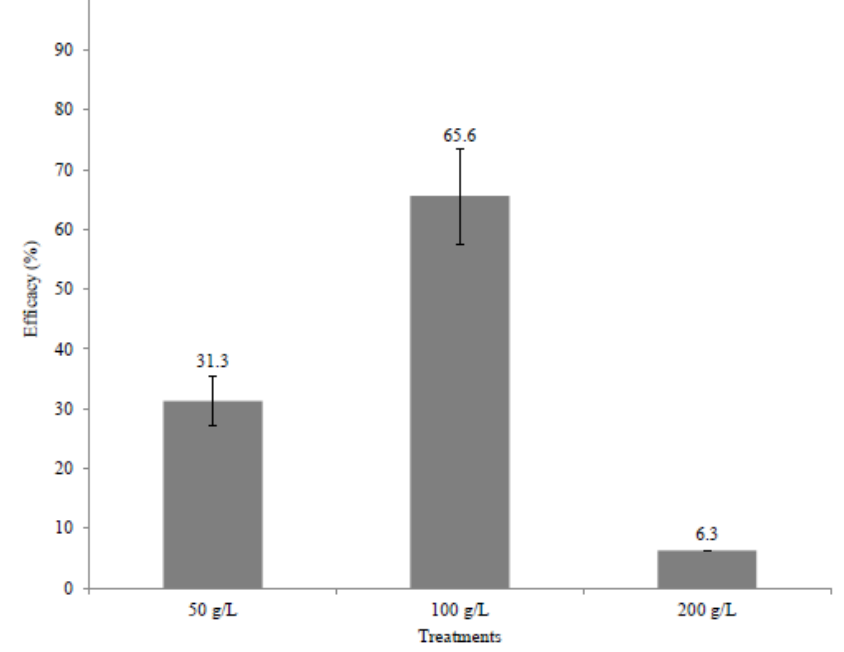
Figure 5. Efficacy of the spray-dried powder containing hydrolytic enzymes in the control of Ceratitis capitata 24 h after